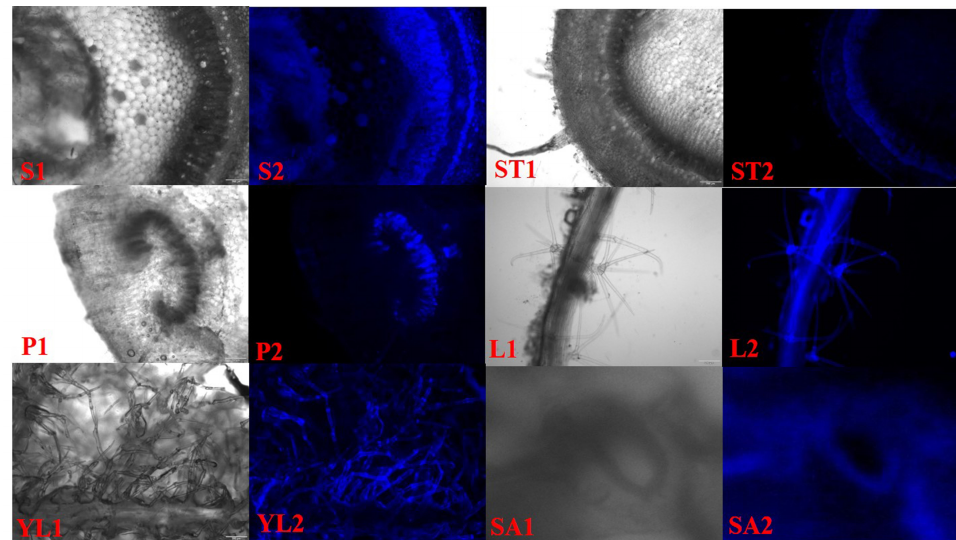
Figure 9. Lignin sections in different tissues of kiwifruit. S. stem, ST. stem tip, P. petiole, L. leaf, YL. young leaf, SA. stomata; 1. bright field, 2. ultraviolet (UV).